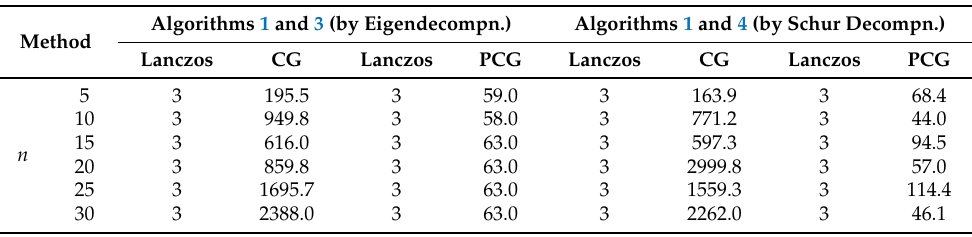
Table 7. Number of iterations of the Lanczos method and the average of numbers of iterations of the CG/PCG method in the case of the 5-th min. singular value of slightly symmetric matrix T with a = c = 1 and b = 0.1 in (9) for the shift (8). Algorithms 1 and 3 (by Eigendecompn.) Algorithms 1 and 4 (by Schur Decompn.) Method